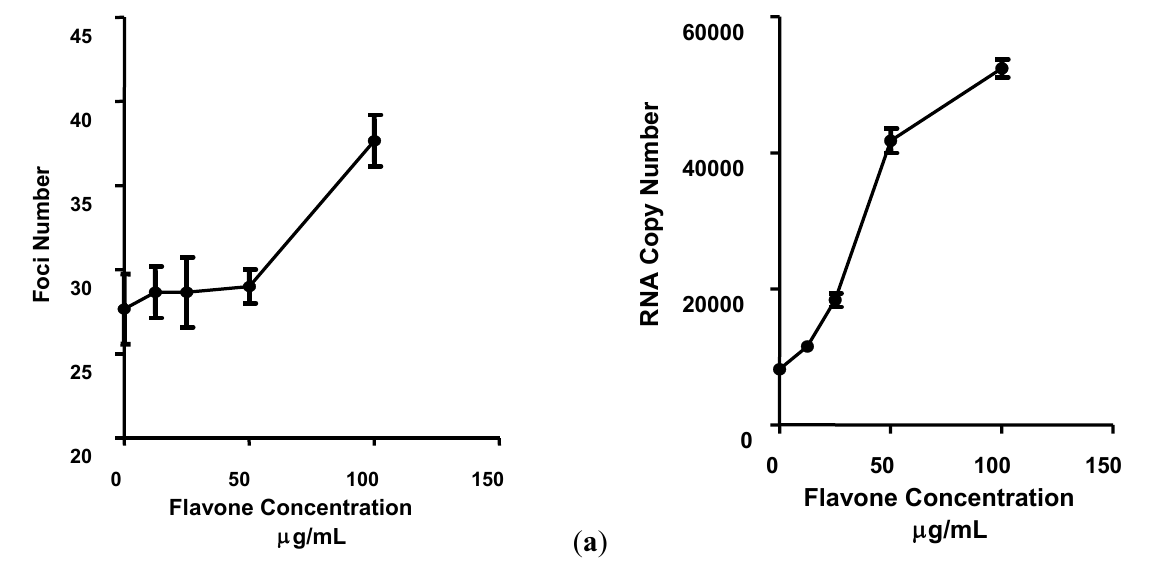
Figure 2. The effects of flavone on DENV-2 infection of Vero cells. Cells were treated with flavone during virus adsorption and the number of foci formed at 4 days post-infection was determined using the foci forming unit assay ( a ) and the respective DENV-2 specific RNA copy number was quantified using qRT-PCR ( b ). All experiments were performed in triplicates. Data (n = 3) were plotted using Graph Pad Prism Version 5.